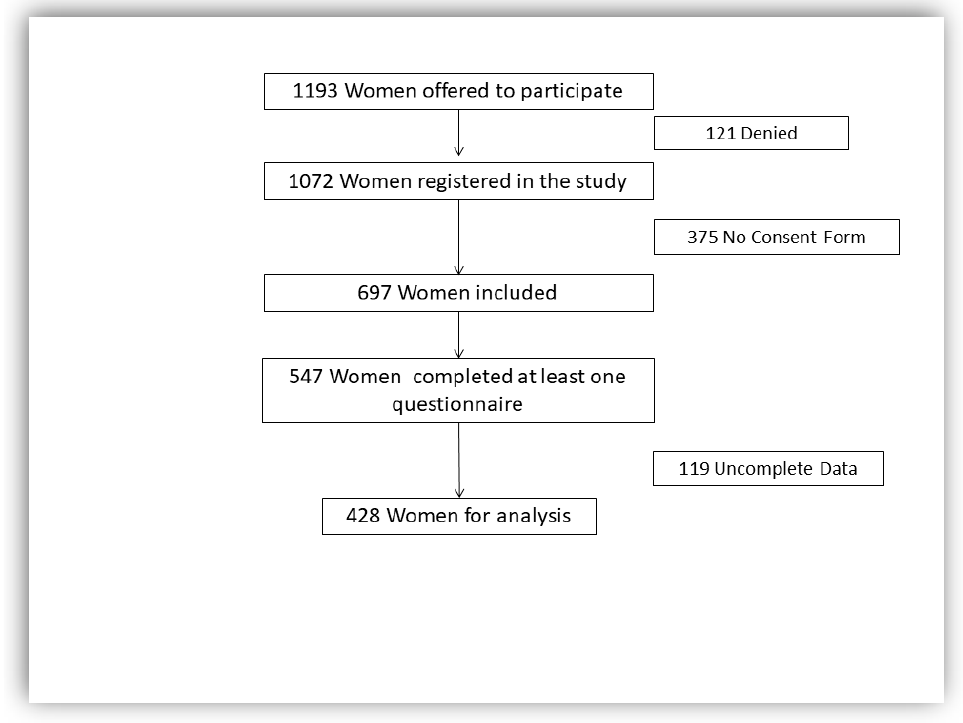
Figure 1. Flow Diagram. Table 1. Maternal demographics, and pregnancy, delivery and neonatal outcomes ( n =